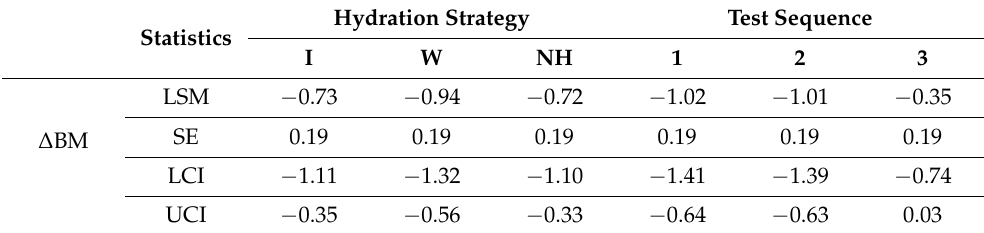
Table 2. Mean values of the change in body mass ( ∆ BM) [kg] between pre-test (preT) and post- test (postT) results in three consecutive tests (1, 2, 3) performed using three different hydration strategies (I, W, NH): marginal means (LSM); standard errors (SE); and lower (LCI) and upper (UCI) confidence